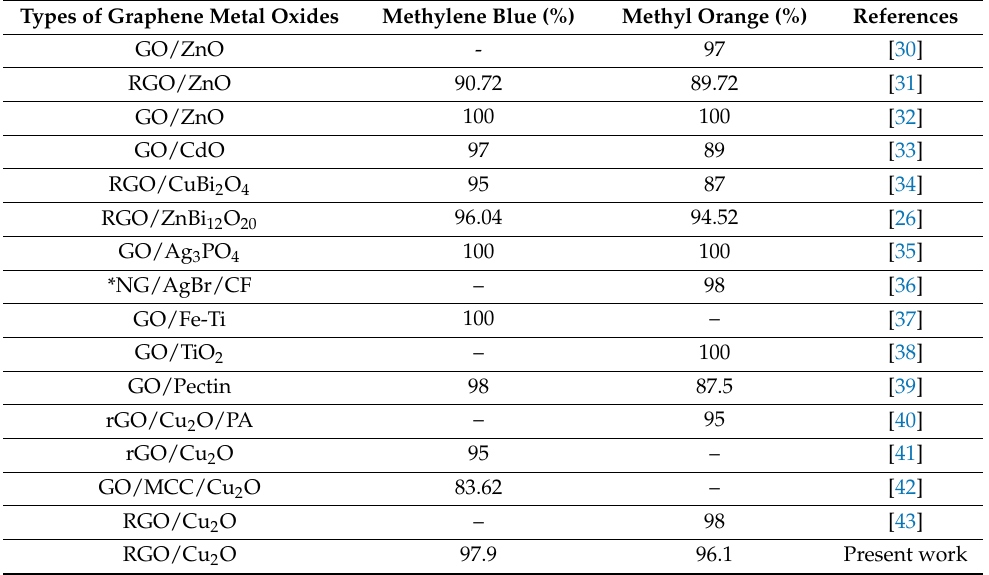
Table 2. Comparison for degradation capacity of present work with reported photocatalyst. Types of Graphene Metal